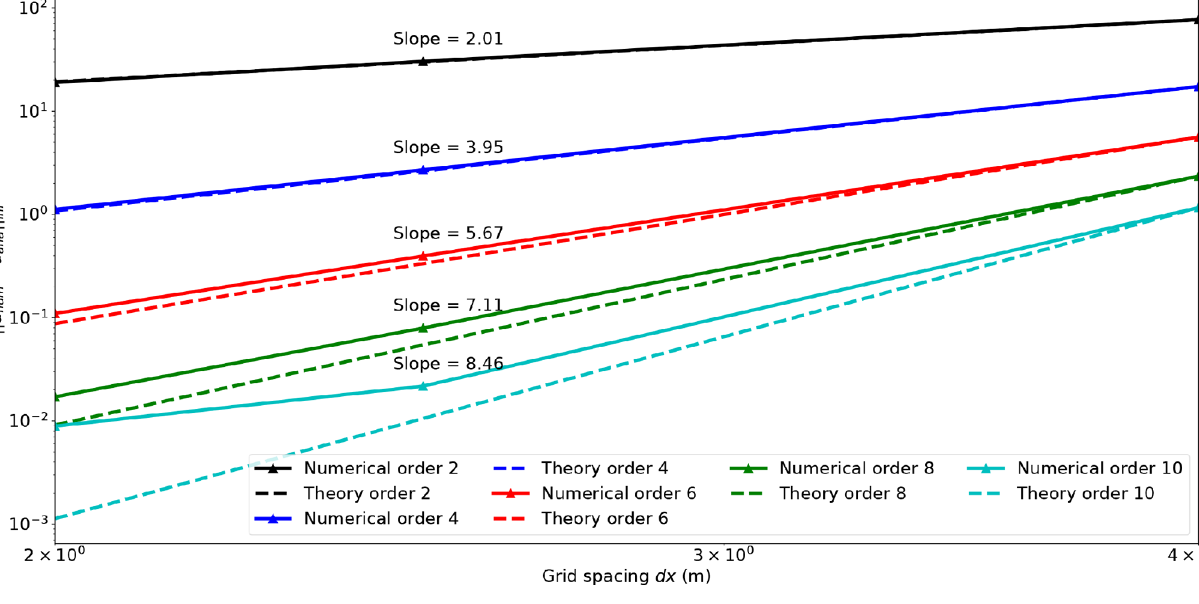
Figure 11. Comparison of the numerical convergence rate of the spatial finite-difference scheme with the theoretical convergence rate from the Taylor theory. The theoretical rates are the dotted line with the corresponding colors. The result is plotted in a logarithmic scale to highlight the convergence orders as linear slopes and the numerical convergence rates show that numerical solution is